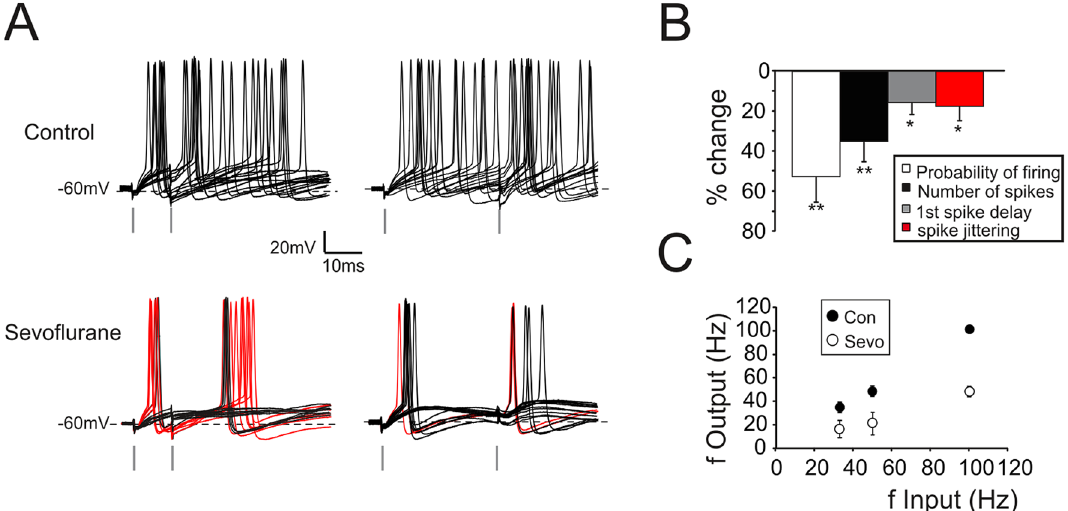
Figure 2. Modulation of GrCs firing activity by sevoflurane. ( A ) Top. Spikes from GrC elicited in response to a pair of stimuli at 100 Hz (left) and 30 Hz (right) (15 superimposed traces). Bottom. Sevoflurane reduces the total number of spikes and the probability of firing in response to the first stimulus. Note that the first spike is anticipated and elicited with a less variable delay. Red traces show responses in which stimuli elicited two spikes. ( B ) Histogram summarizes the effects induced by sevoflurane on spike related parameters (n = 7). ( C ) The plot shows the relationship between input frequency and output frequency in control (Con) and during sevoflurane perfusion (Sevo) (n =